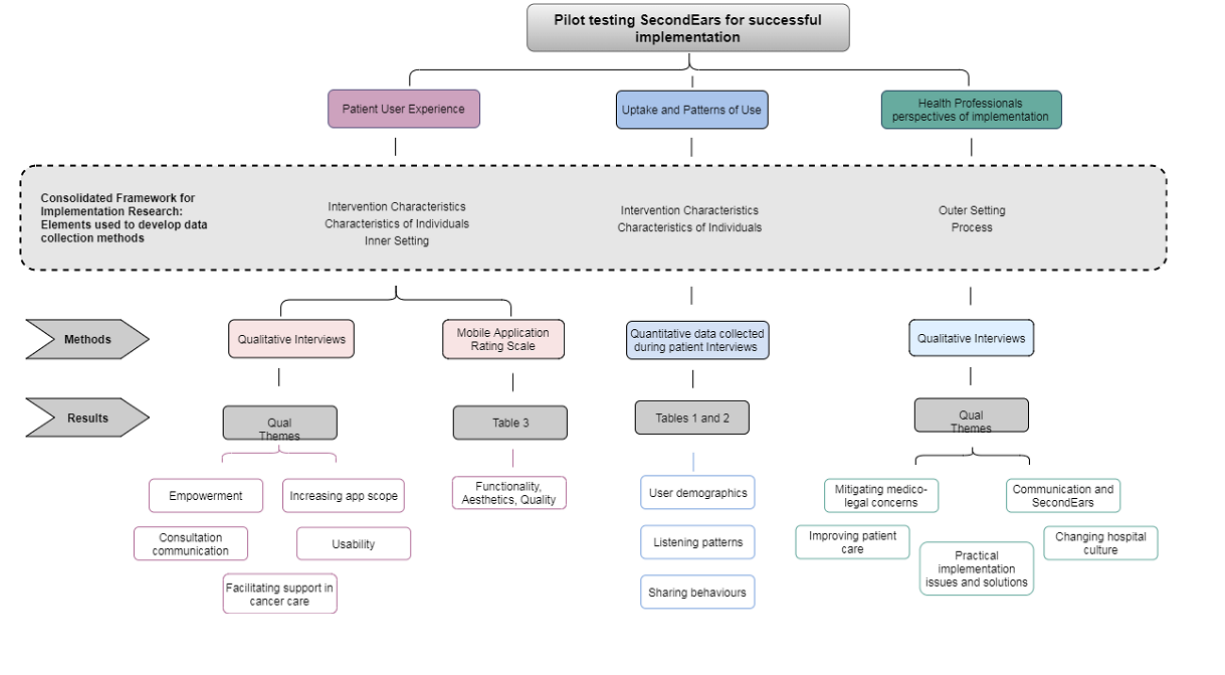
Figure 1. Synthesis of